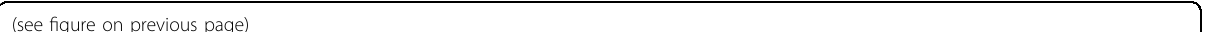
Fig. 2 MMP12 knockdown reduced the cell migration and invasion of human cervical cancer cells both in vitro and in vivo, and MMP12 expression in cervical tumors and its correlation with patient survival rates and MTA2 expression. Cells were transfected with shRNAs against MMP12 (shMMP12). The protein and mRNA expression of MMP12 ( A , B ), cell viability ( C ), and cell migration and invasion ( D ) were then assessed by Western blot, RT-PCR, MTT assay, transmigration assay, and invasion assay, respectively. ( E) Protein expression of MMP12 in cervical cancer tissues was demonstrated using IHC staining. ( F) mRNA expression of MMP12 in normal and tumor tissues in cervical cancer as determined by using the TGCA database. G MMP12 expression between tumor and normal tissues in cervical cancer as determined by using GEPIA. H Kaplan – Meier survival analysis for low and high MMP12 expression in cervical tumor tissues from the TCGA database. ( I) Correlation between MMP12 and MTA2 expression in cervical tumor tissues from the TCGA database. Cells transfected with shLuc was used as sham control. ( J – M) Lung metastasis of shLuc- and shMMP12-SiHa cells in xenograft mice. ( J) Phenotype of lung nodules, ( K ) number of lung nodules, ( L ) lung weights, and ( M ) histological examination of tumor nodules via HE staining and Ki-67 expression by mmunohistochemistry assay. Quantitative results in ( B – D ) were obtained from three